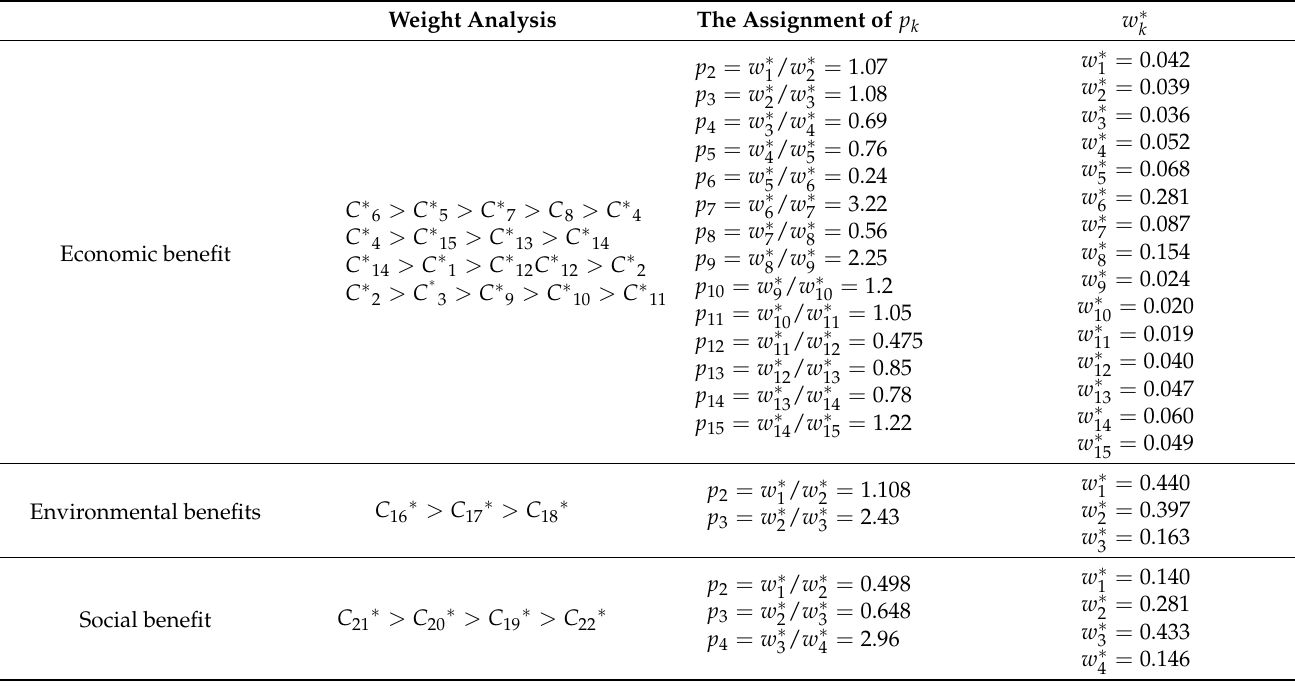
Table 3. Weight analysis and assignment of p k